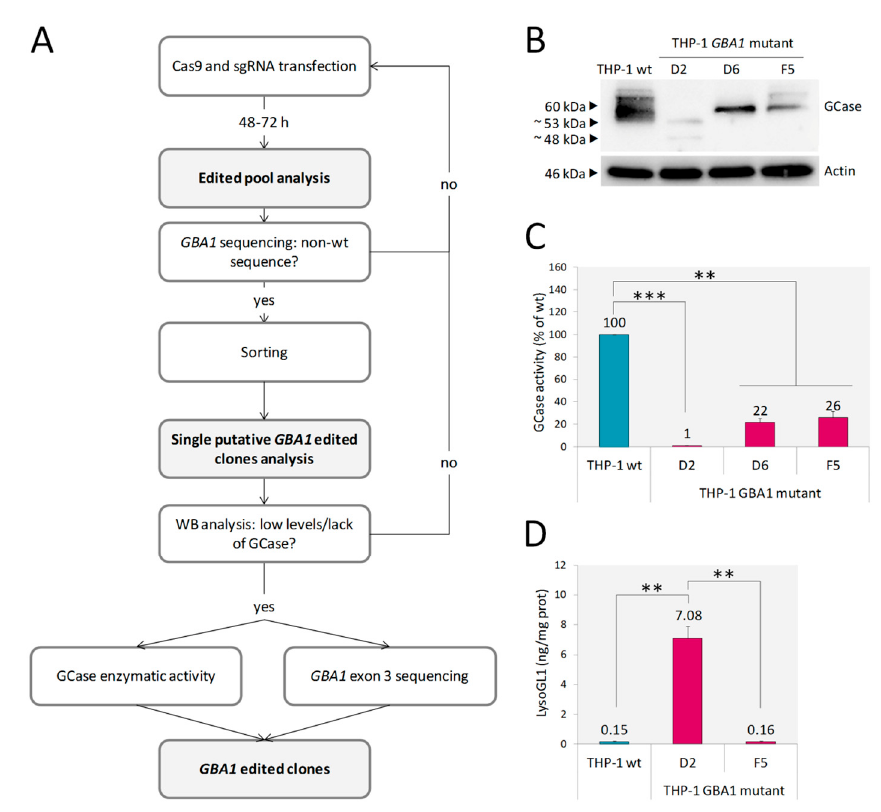
Figure 1. Development and characterization of THP-1 GBA1 mutant cells. Schematic representation